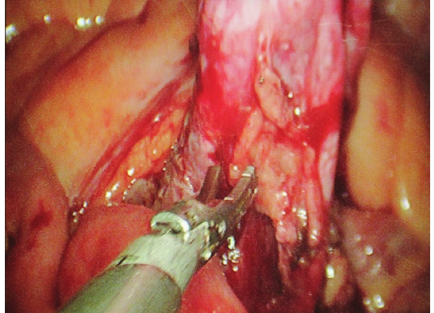
Figure 3: Renal pelvis dissection.